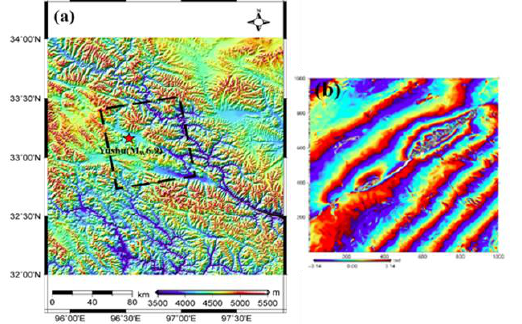
corrected phase (green line) is closer to the true coseismic deformation phase (blue line) than the original phase (red line) in the upper part of the earthquake surface